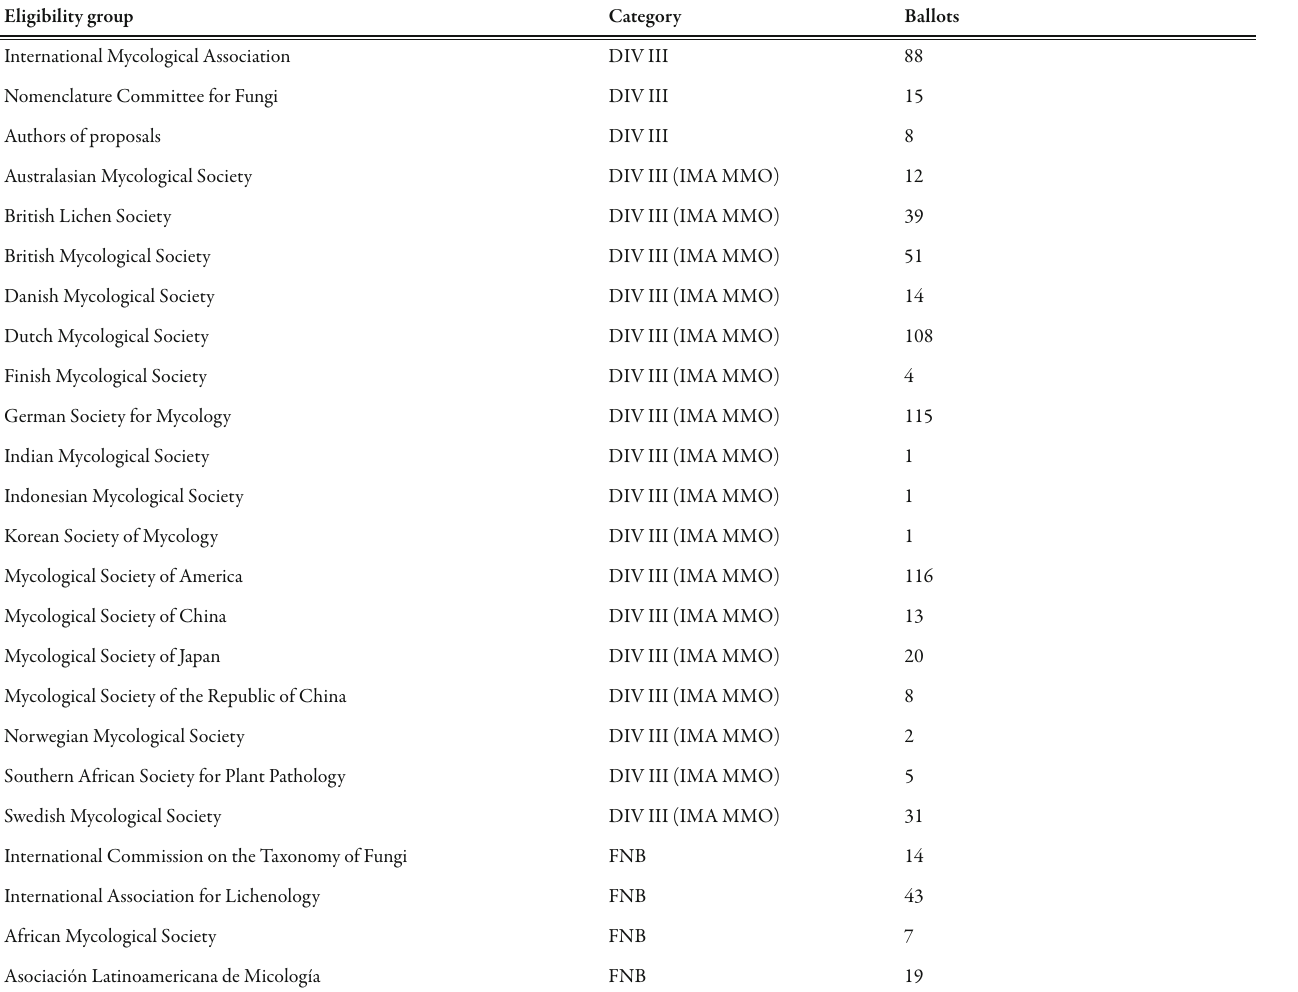
Table 2 . Breakdown of valid ballots by eligibility groups. Note that the total ballots in this table is greater than the number of ballots cast, due to voters often belonging to more than one eligibility group. Categories of eligibility groups include those set out in Provision 8 of Division III of the Code (DIV III), among which are the International Mycological Association (IMA) and societies that are a Member Mycological Organization of the IMA (IMA MMO); along with four additional groups approved by the Fungal Nomenclature Bureau (FNB). Totals do not include incorrect assignments by voters to the eligibility groups ‘Authors of proposals’ and ‘International Commission on the Taxonomy of